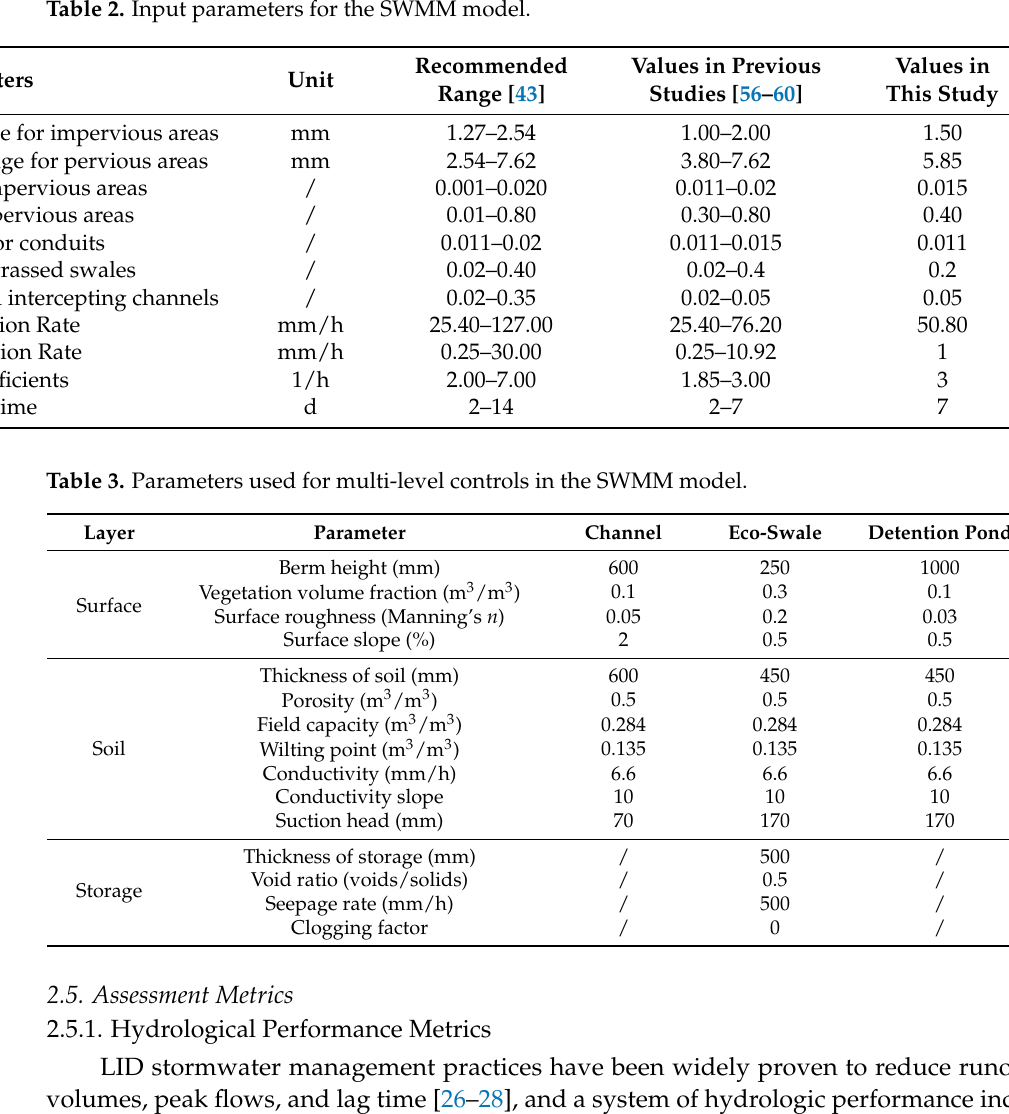
Table 2. Input parameters for the SWMM model.